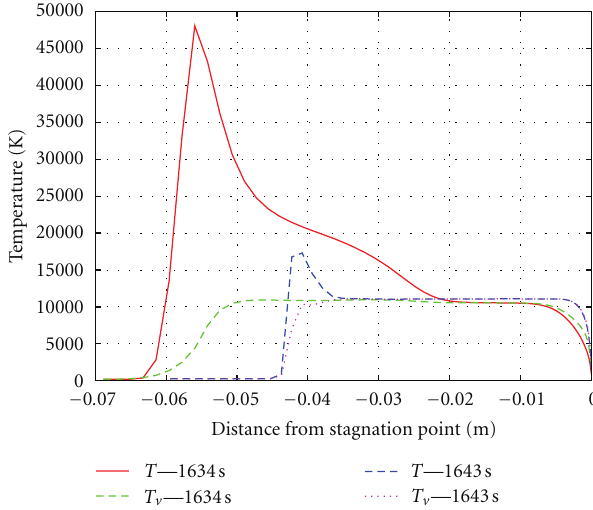
Figure 1: Temperature profiles on the stagnation line for the two trajectory